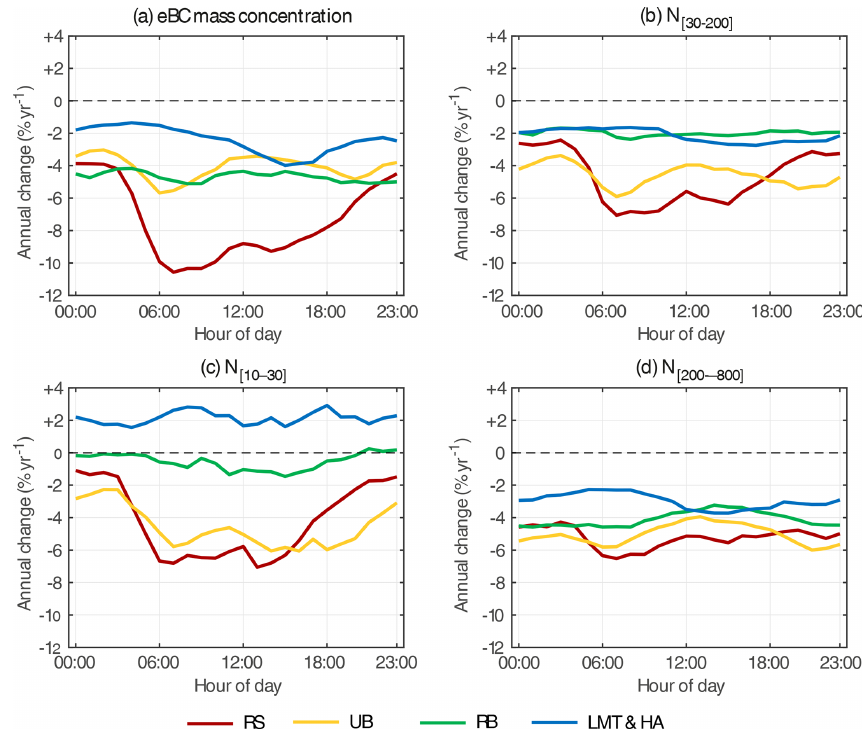
Figure 4. Diurnal variations in the trends of PNCs and eBC mass concentration for the four site categories (RS: roadside; UB: urban background; RB: regional background; LMT&HA: low mountain range and high